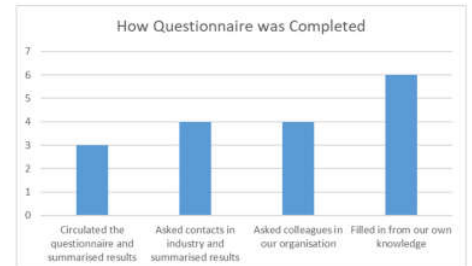
Figure 2 - Different approaches to questionnaire completion taken by the